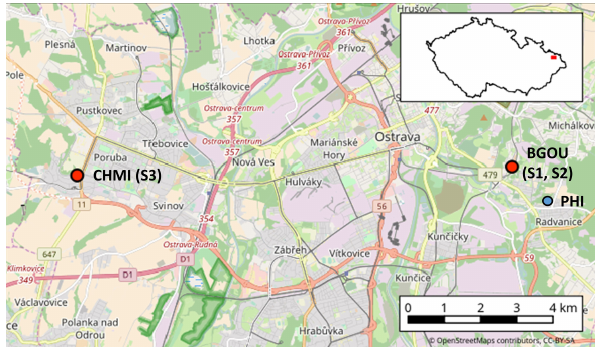
Figure 1. Locations of the measuring stations. CHMI: Czech Hy- drometeorological Institute area (station S3); BGOU: Botanical Garden of the University of Ostrava (stations S1 and S2); PHI: mea- suring station of the Public Health Institute of Ostrava. Map data copyrighted OpenStreetMap